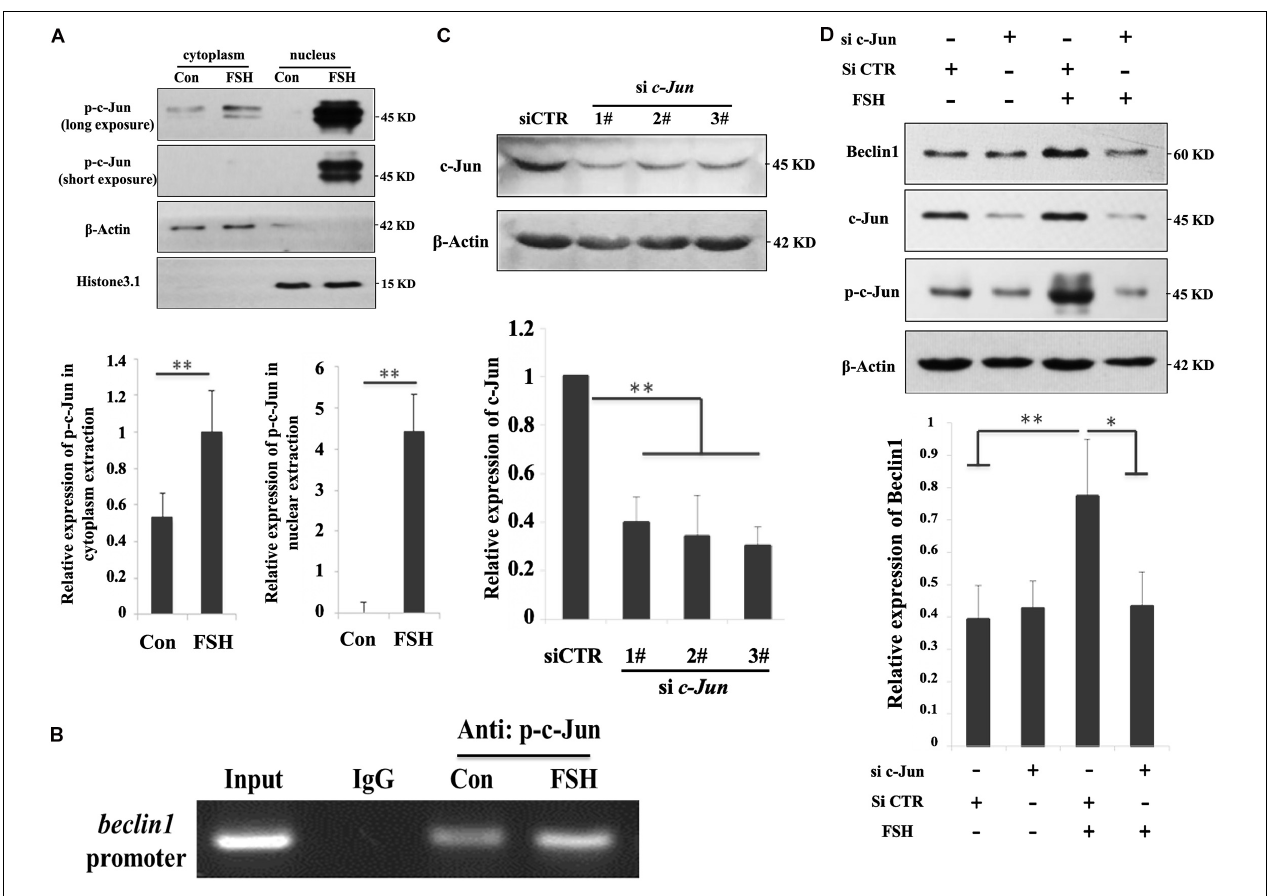
FIGURE 3 | C-Jun was directly involved in beclin1 transcription in response to FSH treatment. (A) GC mass were cultured in DMEM/F12 medium containing 0.01 IU/mL FSH for 24 h, and nuclear and cytoplasmic fractions were prepared from granulosa cells and analyzed by western blotting using the indicated antibodies. Histone 3.1 and β -actin served as the fractionation and loading controls, respectively. ∗∗ , P < 0.01 compared to the control group. (B) GC mass were cultured in DMEM/F12 medium containing 0.01 IU/mL FSH for 24 h, the cells were lysed, CHIP assays were performed, chromatin fragments were immunoprecipitated with antibodies against p-c-Jun antibody or normal rabbit IgG, and the beclin1 promoter was amplified by PCR. The graph of RT-PCR data represents the relative binding by p-c-Jun to the specified DNA-binding elements. (C) GC mass were transfected with c-Jun siRNAs (si c-Jun 1-3 # ) and control scramble siRNA (si-CTR) for 24 h and were then harvested and analyzed by immunoblotting with antibodies against c-Jun and actin. (D) GC mass were transfected with 3 # c-Jun siRNA (si-c-Jun) and control scramble siRNA (si-CTR). At 20 h after transfection, the cells were treated with 0.01 IU/mL FSH for 24 h before harvesting. C-Jun, p-c-Jun, beclin1, and actin were detected in the whole cell lysates. ∗ , p < 0.05; ∗∗ , P < 0.01 compared to the control